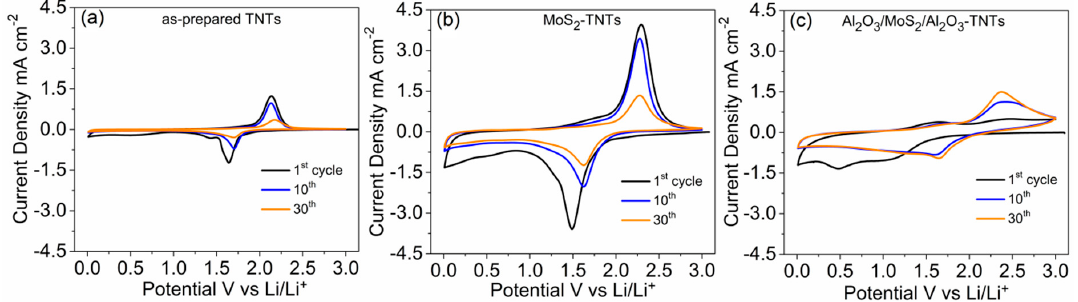
Figure 3. Cyclic voltammograms of ( a ) as-prepared TNTs, ( b ) MoS 2 -TNTs and ( c ) Al 2 O 3 /MoS 2 /Al 2 O 3 -TNTs recorded at a scan rate of 1 mV s − 1